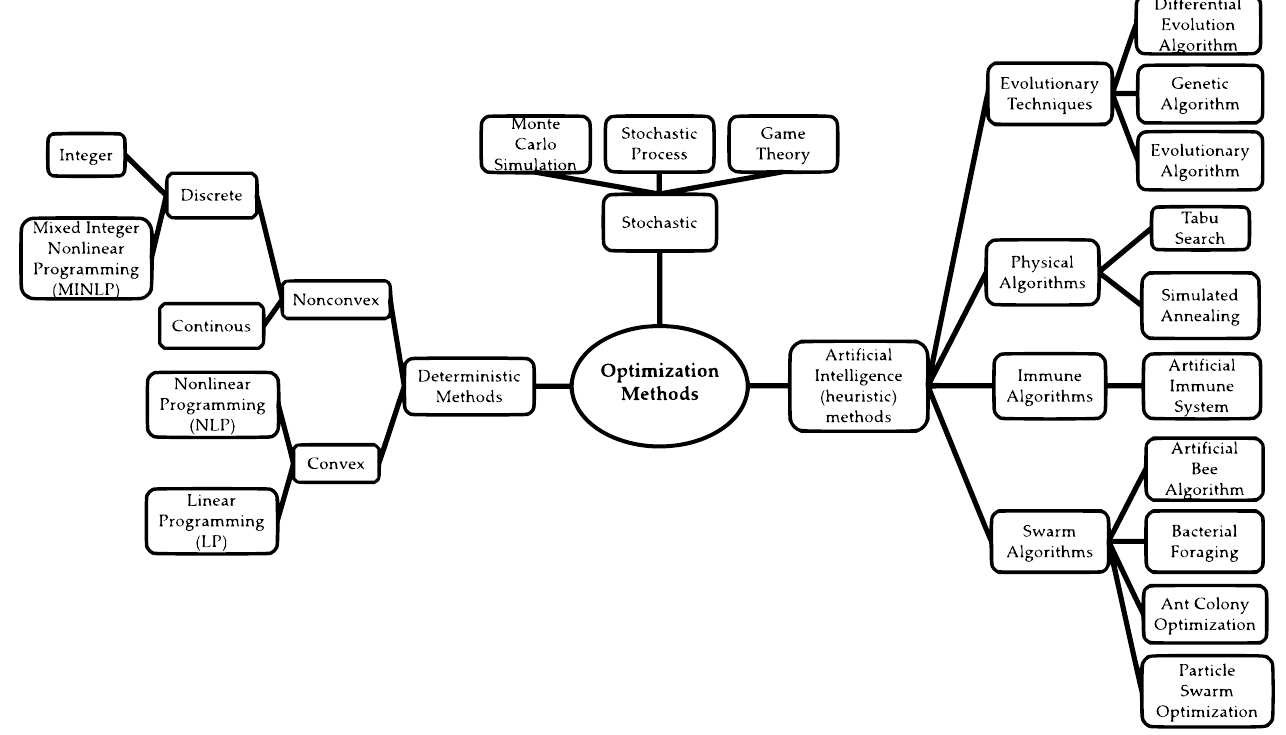
Figure 5. Optimization